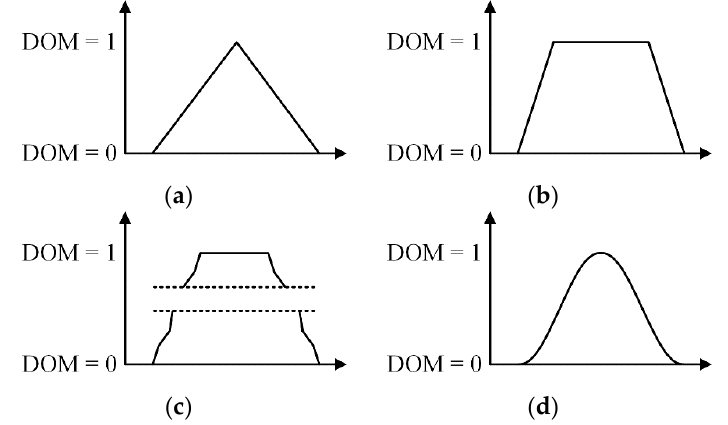
Figure 7. Various shapes of membership function. ( a ) Triangular; ( b ) Trapezoidal; ( c ) Polygonal; ( d ) Gaussian.